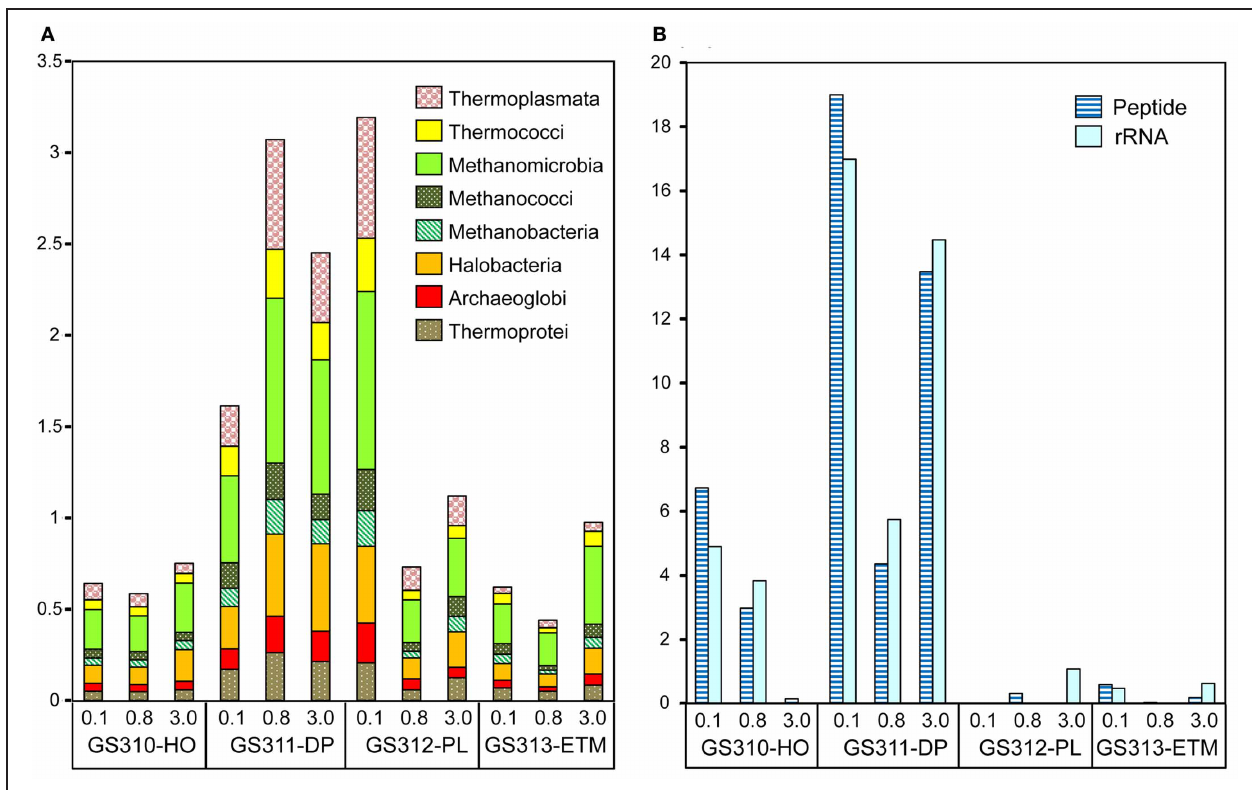
FIGURE 3 | Taxonomic composition of the domain Archaea sequences in metagenomes. (A) Euryarchaeota and Crenarchaeota class abundance was calculated as a percentage of the corresponding hits (with ≥ 30% sequence identity over > 70% of the alignment length) to the total predicted prokaryotic peptides. (B) Thaumarchaeota, Marine Group I, and Nitrosopumilus maritimus -like organism abundance was calculated either as percentage of